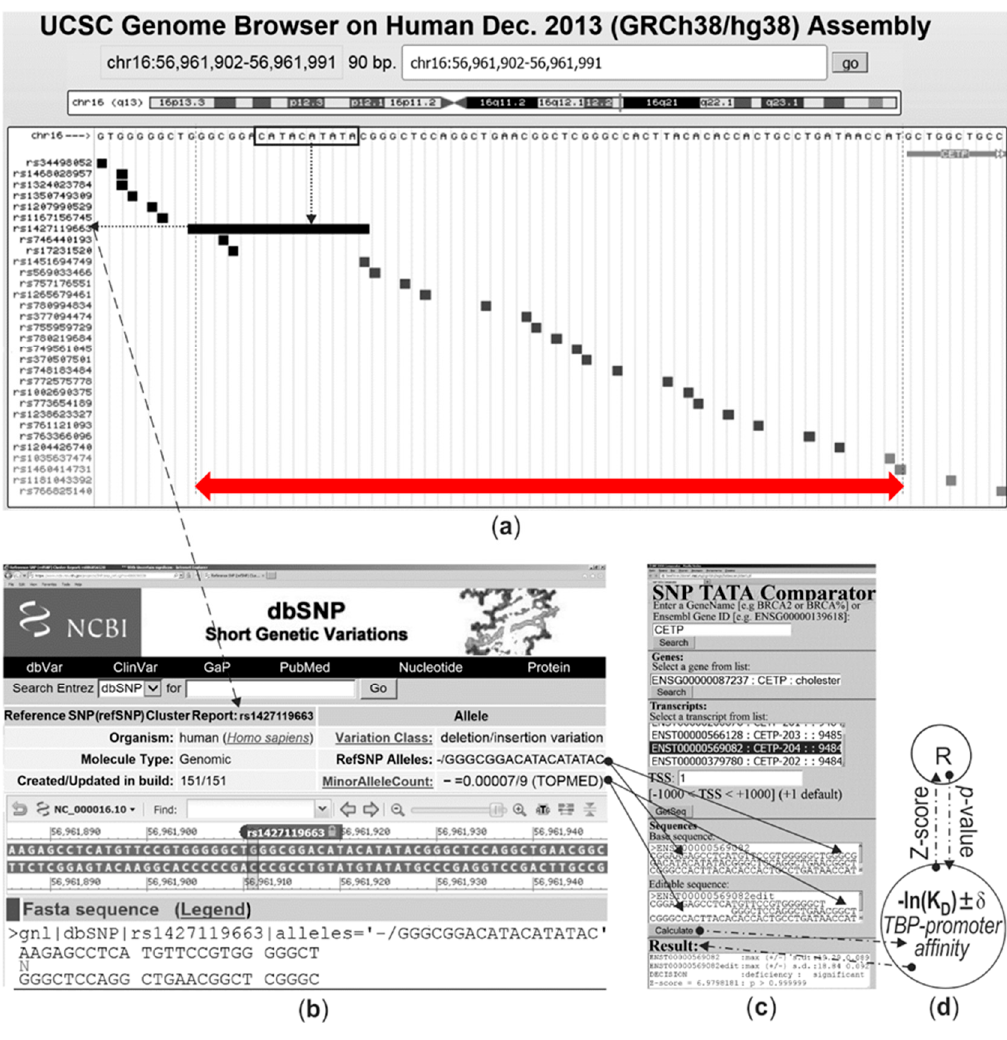
Figure 1. The result produced by our SNP_TATA_Comparator [45] in the case of the only known clinical SNP marker (rs1427119663) of slowed atherosclerosis in the human CETP gene. Legend: ( a ) Unannotated SNPs (analyzed in this study) in a 70 bp proximal promoter [where all proven TBP-sites (framed, □ ) are located (double-headed red arrow, ↔ ) of the human CETP gene retrieved from the UCSC Genome Browser [13]. ( b ) The description of this clinical SNP marker (rs1427119663) of retarded atherosclerosis corresponds to dbSNP build No. 151 [12]. ( c ) The output of our public Web service SNP_TATA_Comparator [45] after the input of data on the clinical SNP marker rs1427119663 as depicted by arrows (i.e., the textbox Result: “deficiency: significant” in line “Decision”). (d) Our software-based calculation implementing our bioinformatics model of the three-step TBP-promoter binding (i.e., TBP slides along DNA <=> TBP stops at a TBP-site <=> the TBP-promoter complex is fixed by a 90° DNA bend [36]), based on standard bioinformatics-related software R [59], as described in detail within Supplementary Materials (Supplementary File S1: Supplementary Methods).